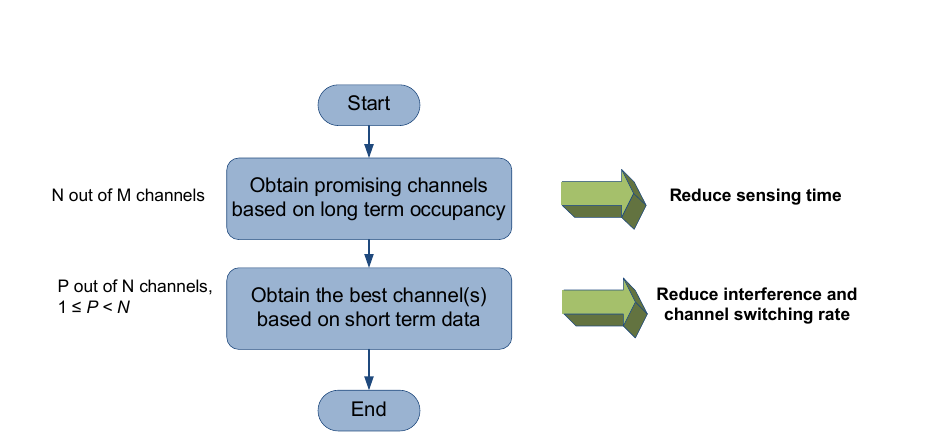
Figure 2. Simplistic view of the proposed